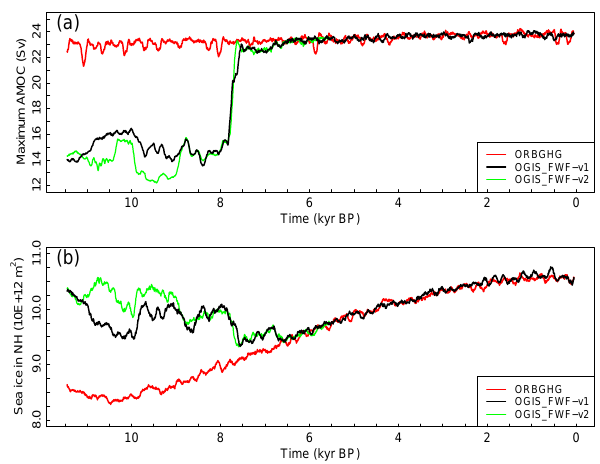
Figure 14. Response of the ocean variables (shown as a 100-year average) to forcings during the Holocene. (a) Maximum meridional overturning stream function (Sv) in the North Atlantic. (b) Sea-ice area (10 12 m 2 ) in the Northern